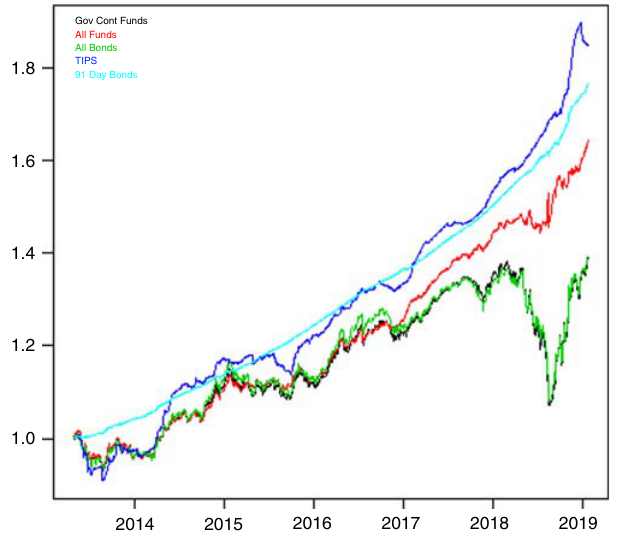
Figure 6. Performance of